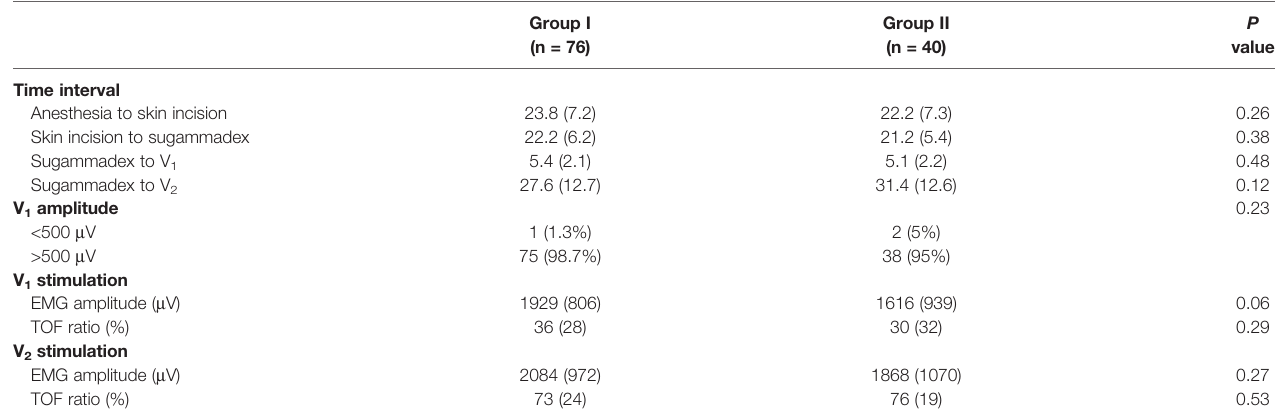
TABLE 3 | Time interval of procedures and quality of intraoperative neural monitoring comparison of neuromuscular blockade degree, neural monitoring recordings, and postoperative adverse events.